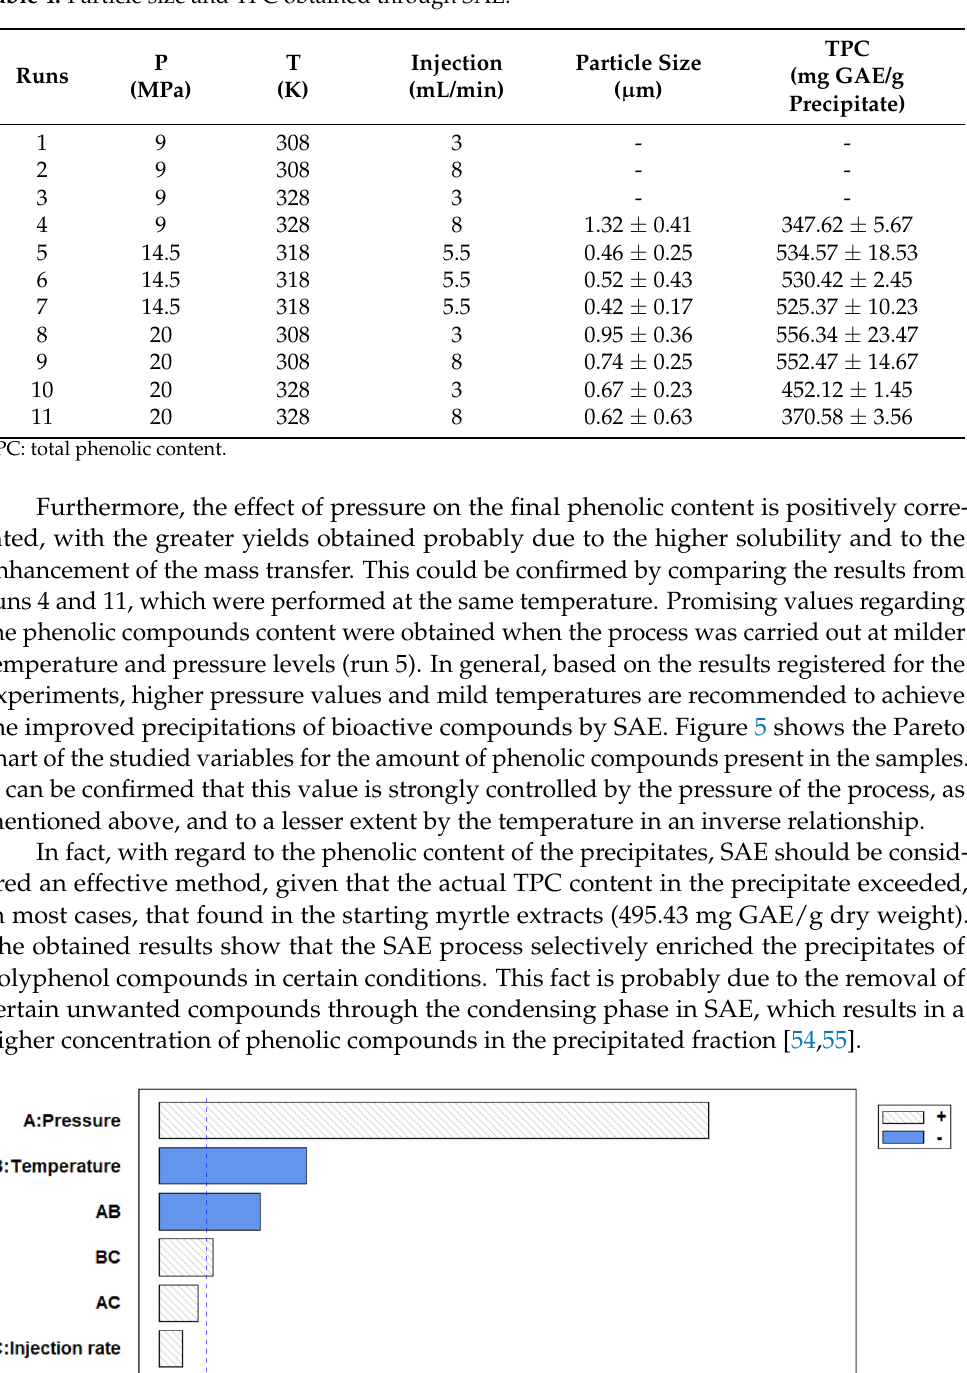
Table 4. Particle size and TPC obtained through SAE.